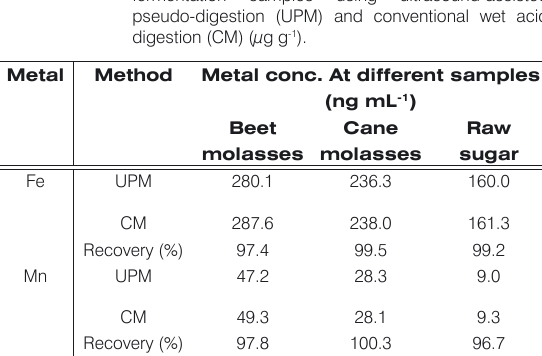
Table 3. Determination of iron and manganese in different fermentation samples using